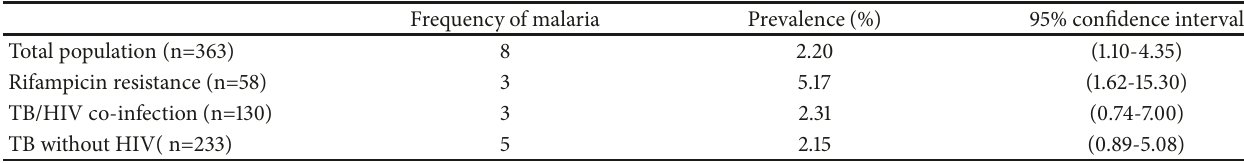
Table 3: Prevalence of malaria among patients with TB.